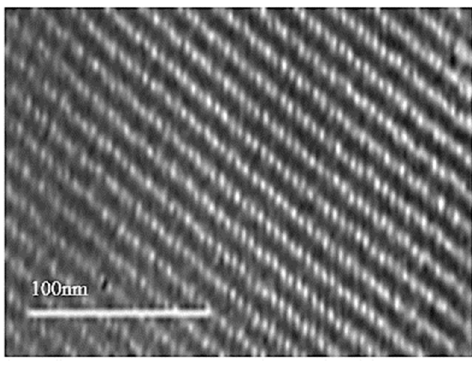
Figure 2. HRTEM image of KIT-6.